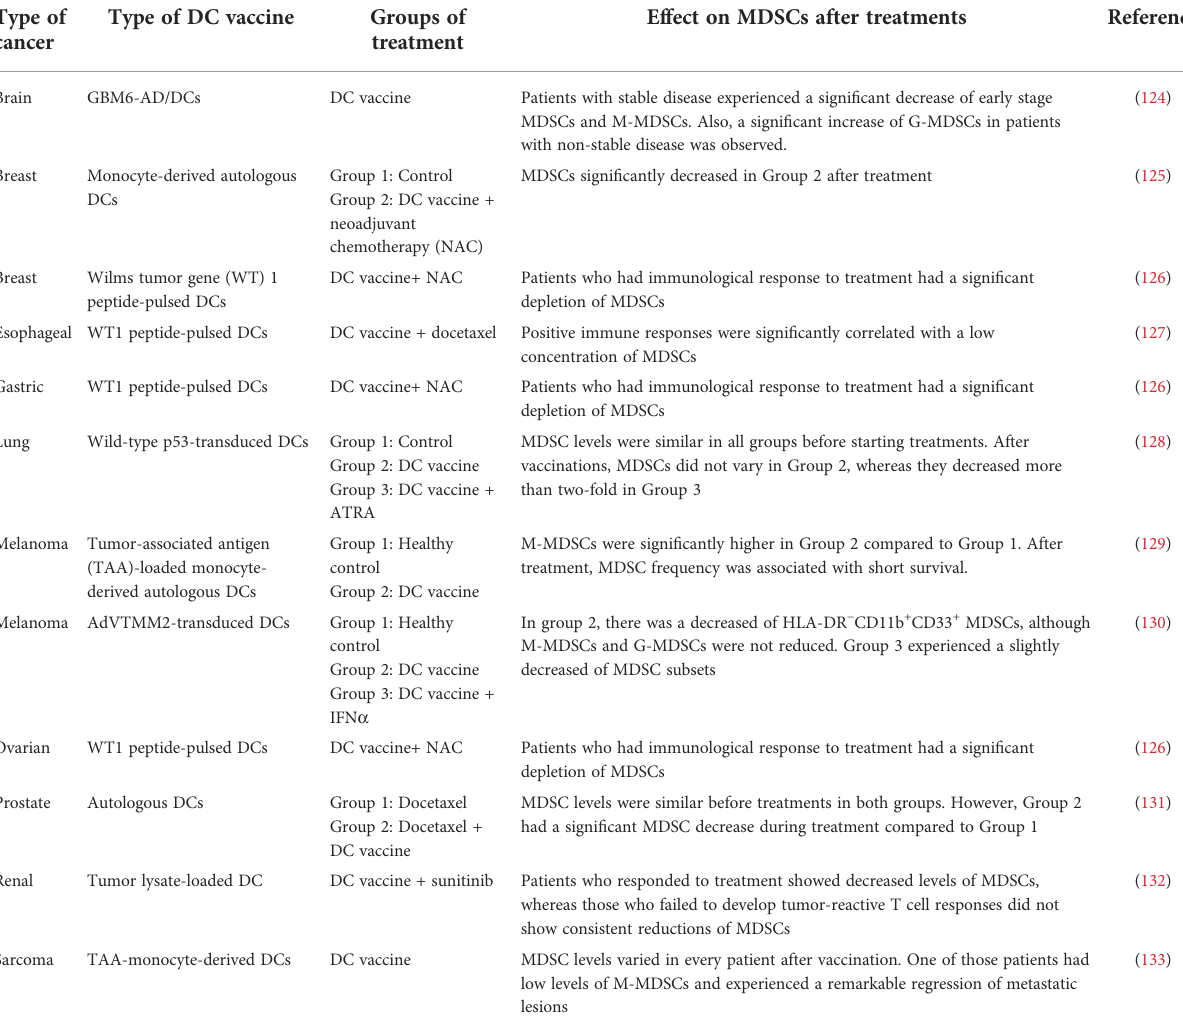
TABLE 2 Clinical studies involving the use of dendritic cell-based vaccines (alone and combined with other treatments) and their effects on the myeloid-derived suppressor cell population. Type of